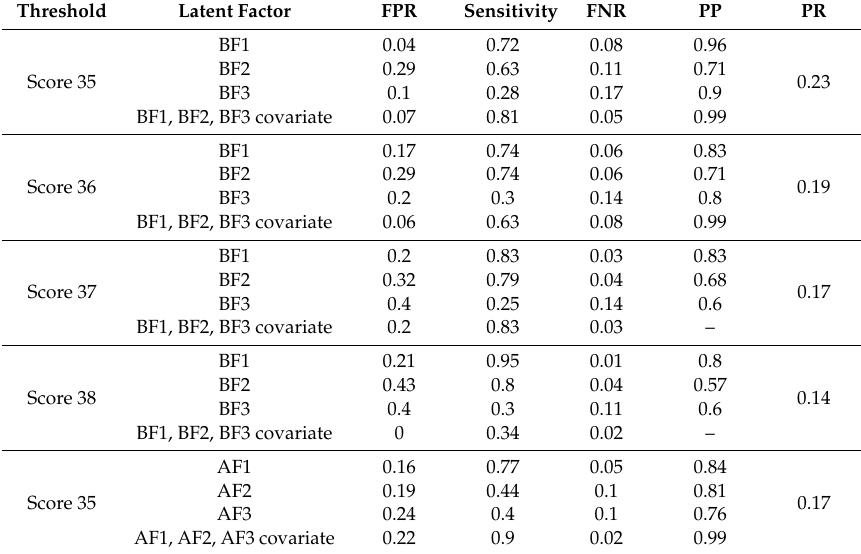
Table 3. List of three latent factors BF1, BF2, and BF3 analyzed before attending in the jogging class, and AF1, AF2, and AF3 after attending in the jogging class with the threshold score, false positive rate (FPR), sensitivity, false negative rate (FNR), predictive probability (PP), and the prevalence rate (PR) computed from binary logistic regression model for latent